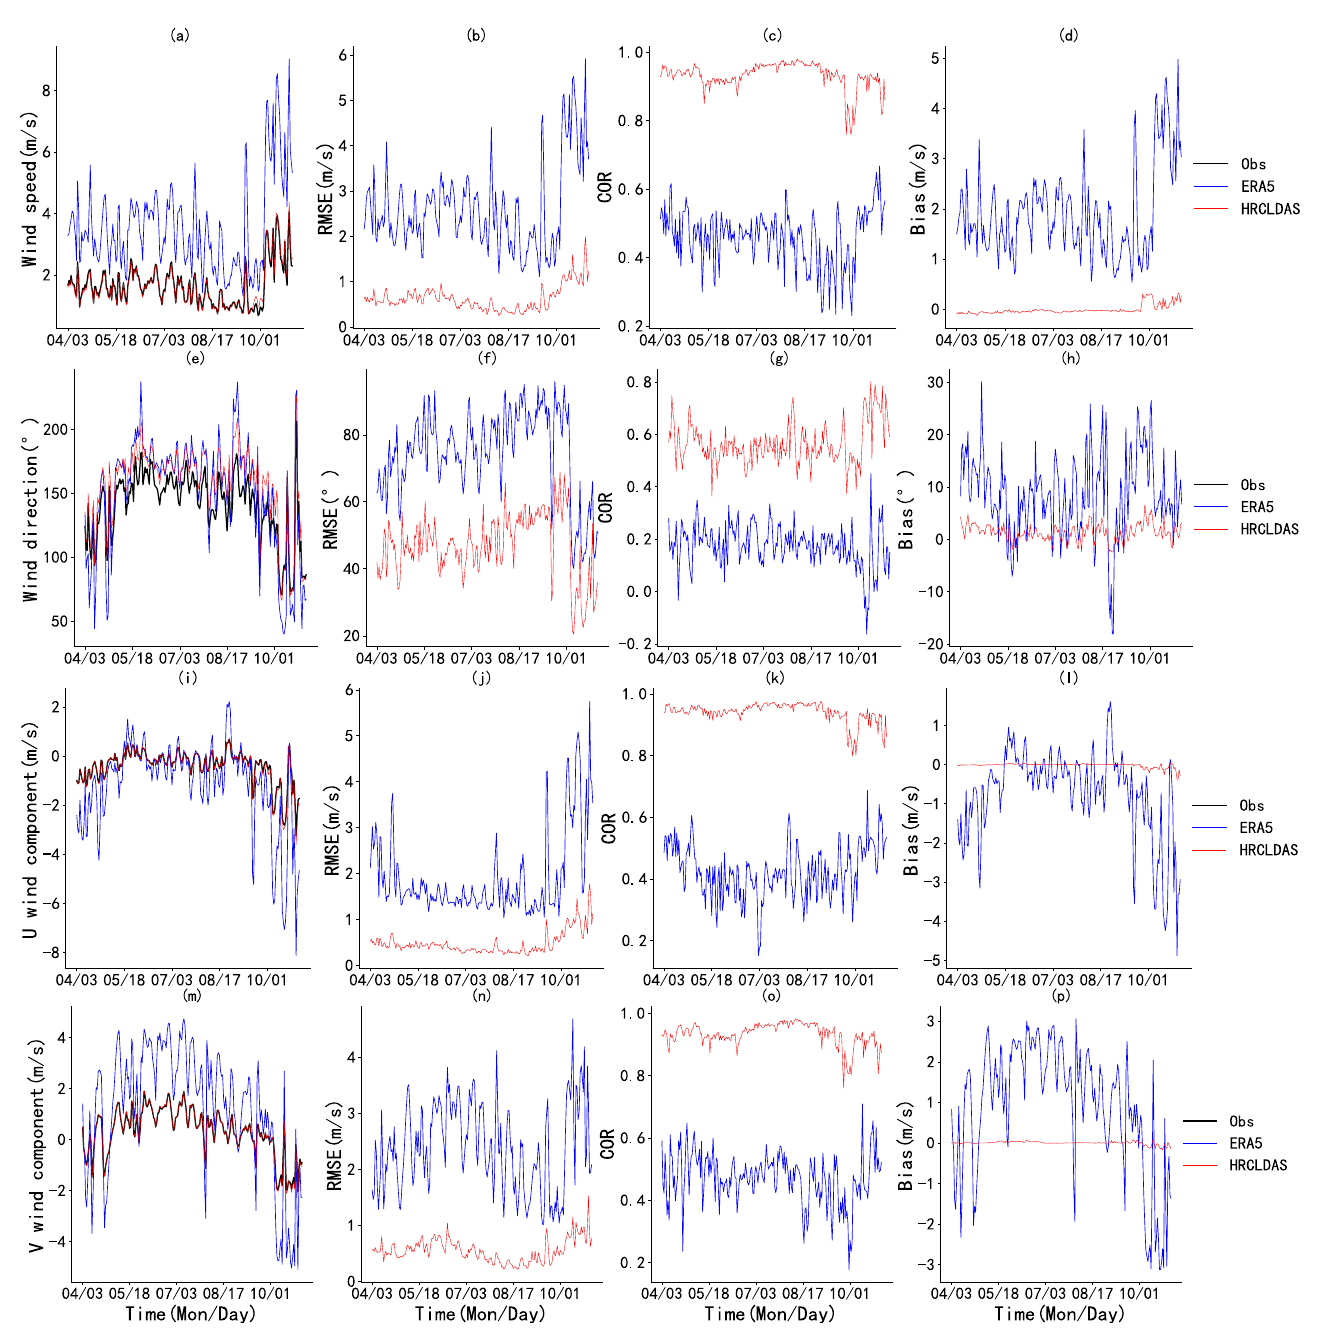
Figure 2. Time series of daily average near-surface ( a ) wind speed, ( e ) wind direction, ( i ) U component, and ( m ) V component; RMSE time series of ( b ) wind speed, ( f ) wind direction, ( j ) U component, and ( n ) V component; COR time series of ( c ) wind speed, ( g ) wind direction, ( k ) U component, and ( o ) V component; bias time series of ( d ) wind speed, ( h ) wind direction, ( l ) U component, and ( p ) V component.